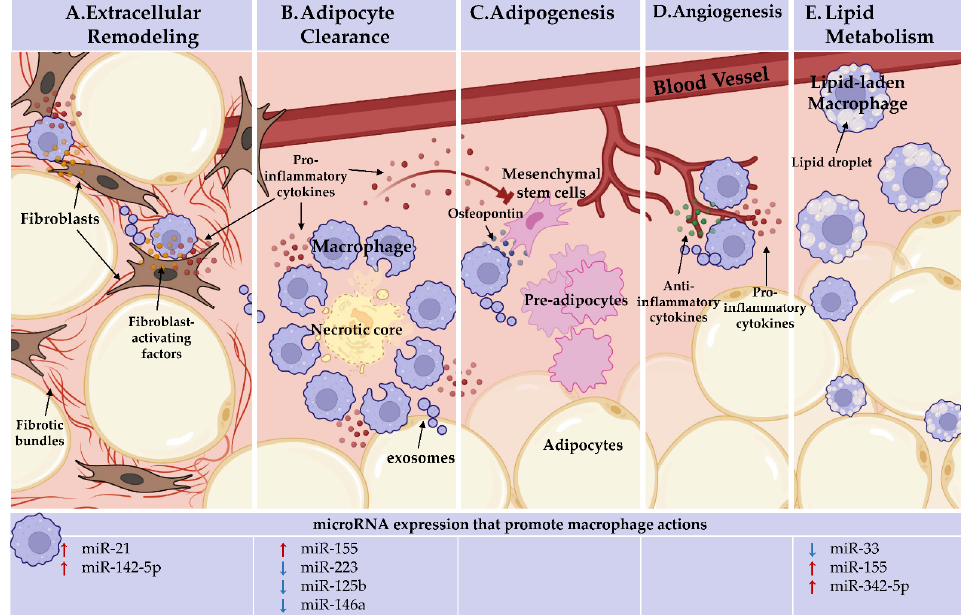
Figure 1. Adipose tissue macrophages (ATMs) perform heterogeneous, niche-specific functions and under obese stress perpetuate pathologic inflammation. In the top panel, ATM functions. In the bottom panel, the microRNAs known to endorse (red arrows) or inhibit (blue arrows) these macro- phage actions are detailed. ( A ) Extracellular remodeling: ATMs support AT extracellular matrix re- modeling. ATMs can activate fibroblasts through direct interactions and paracrine signaling, li- censed by miR-21 and miR-142-5p, to increase tissue fibrosis under obesity. ( B ). Adipocyte clear- ance: pro-inflammatory ATMs clear dead and dying adipocytes in crown-like structures (CLS) and miR-155 supports, whereas miR-223, miR-125b, and miR-146a repress pro-inflammatory macro- phage activation. ( C ) Adipogenesis: ATMs recruit progenitor cells through osteopontin secretion. Inflammatory ATM cytokine signaling within CLS, which miR-155, miR-223, miR-125b, and miR- 146a regulate, impacts progenitors. ATMs may deliver microRNAs through exosomes to regulate adipogenesis. No endogenous role for microRNAs in ATM promotion of adipogenesis has been identified. ( D ) Angiogenesis: pro-inflammatory and anti-inflammatory-activated macrophages are required for de novo vessel outgrowth. Similar to adipogenesis, ATM may regulate angiogenesis through microRNA-containing exosomes. Beyond the importance of macrophage activation status, no endogenous role for microRNAs in ATM promotion of angiogenesis has been identified. ( E ) Li- pid metabolism: ATMs uptake and metabolize lipids. Macrophage lipid efflux is repressed by miR- 33. MiR-155 and miR-342-59 may play a role as they are upregulated during fatty plaque formation in vessels (atherosclerosis), but their networks towards lipid efflux has not been defined. Figure Created with BioRender.com (accessed on 13 February 2022). Author Contributions: A.M. and B.Z. wrote and revised the manuscript. L.Q. and K.K. contributed to manuscript design and revisions. All authors have read and agreed to the published version of the manuscript. Funding: This research was funded by the American Heart Association grant 19TPA34910079 and National Institutes of Health/National Institute of Diabetes and Digestive and Kidney Diseases R01DK121805 to B.Z. Institutional Review Board Statement: Not applicable. Informed Consent Statement: Not applicable.